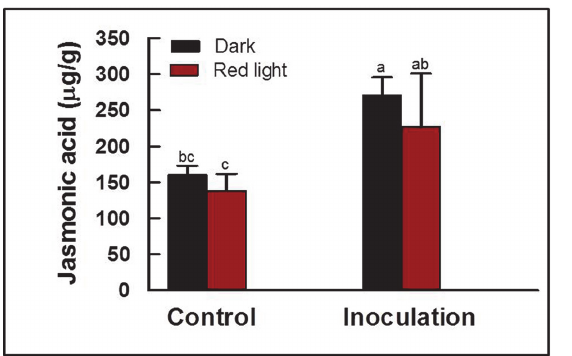
Fig 4. Content of jasmonic acids (JA). Content of JA in soybean sprouts germinated in darkness or under red light was analyzed. JA contents in the soybean hypototyls were measured without inoculation of Pseudomonas putida 229 (control), or with inoculation for 8 h followed by incubation in darkness for 24 h (inoculation). These experiments were repeated two times. Different letter indicates a significant difference ( P <